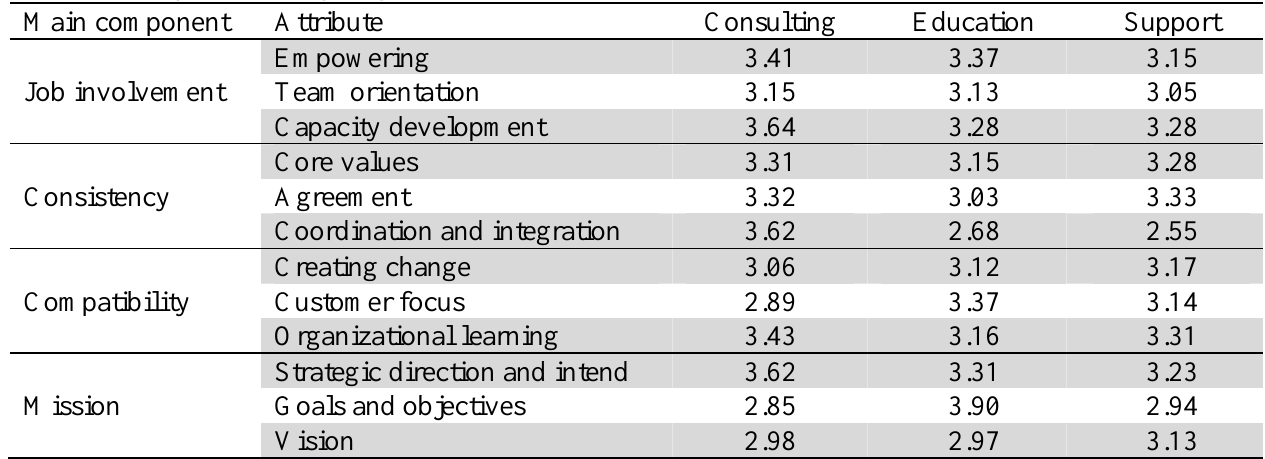
Table 1 The summary of the weights given to each sub-component of Denison model Main component